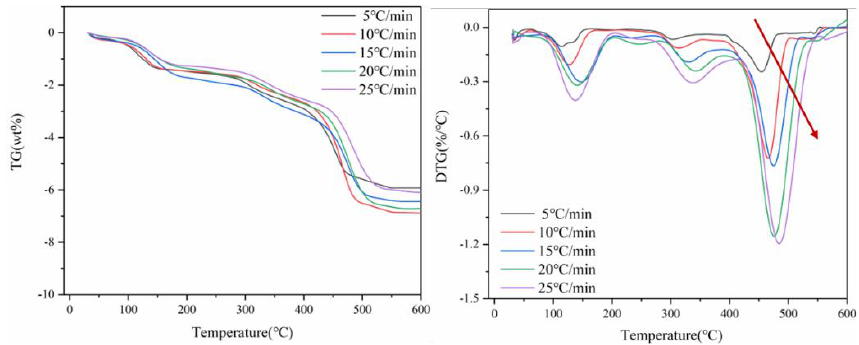
Figure 2. Curves of TG and DTG of battery materials at four heating rates.